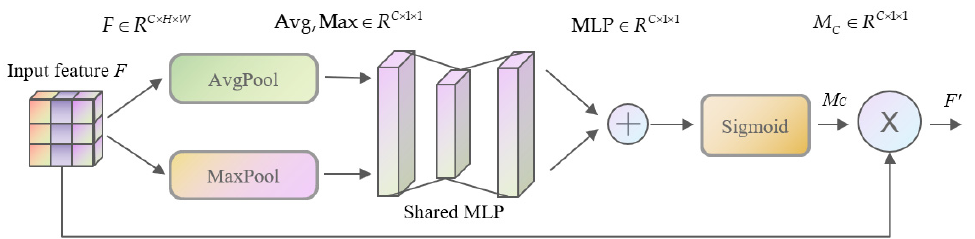
Figure 5. Structure of the channel attention module.